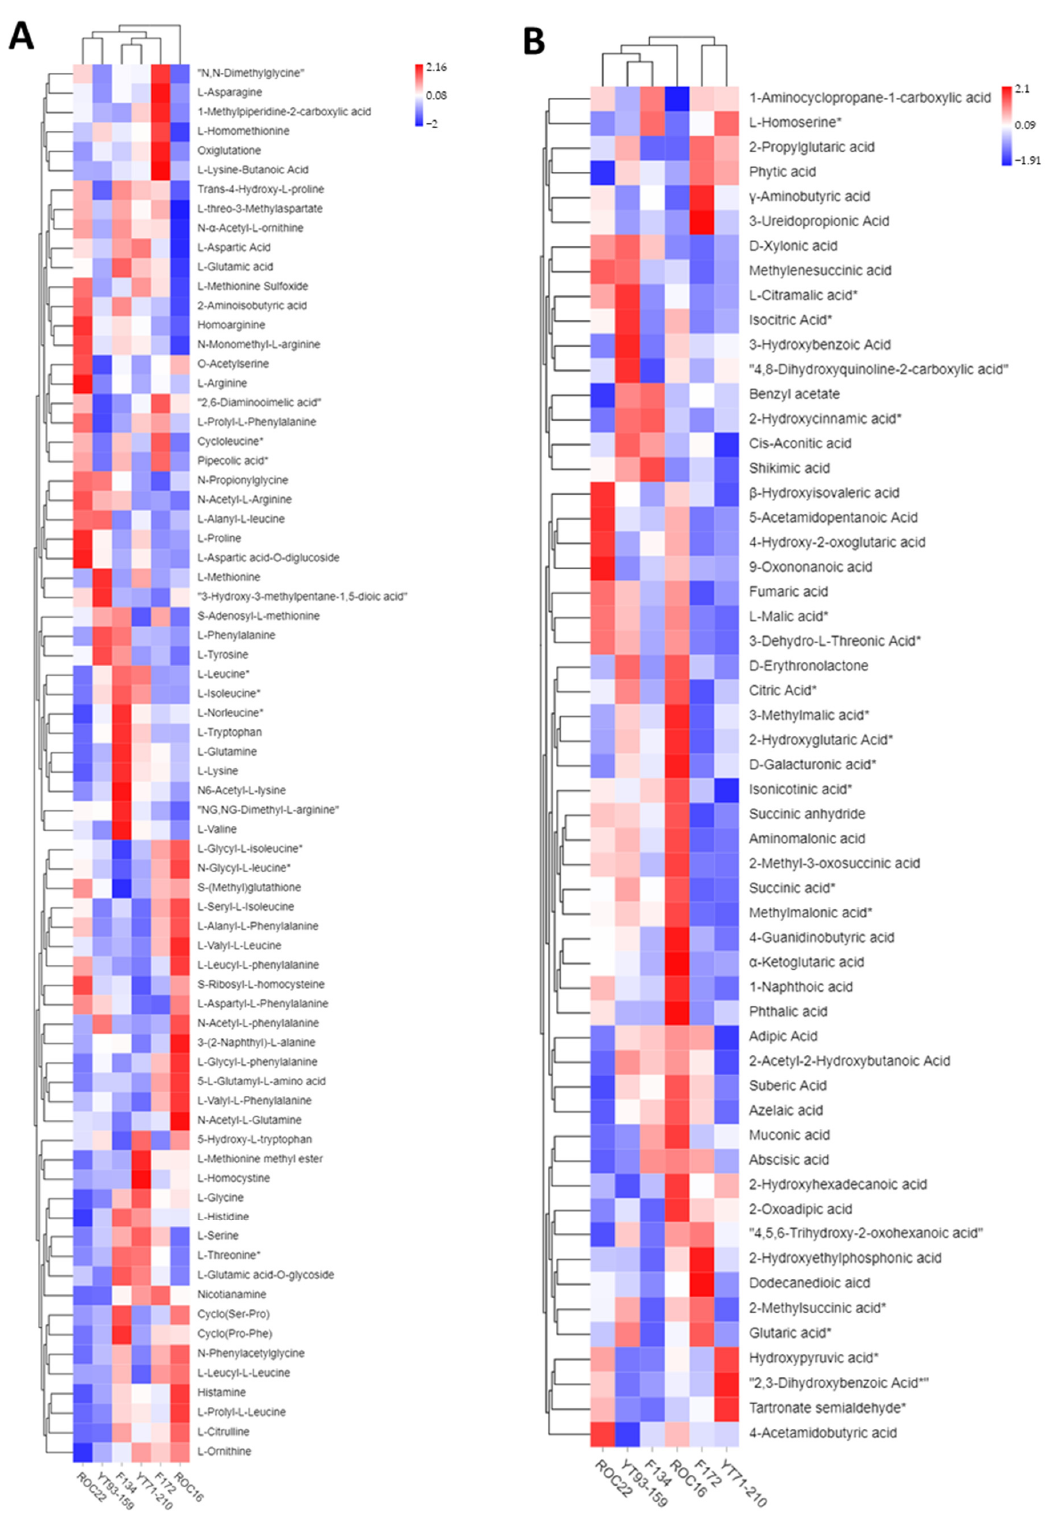
Figure 1. Hierarchical cluster analysis and heat map of amino acid and organic acid compounds in the rind of six sugarcane varieties. ( A ) HCA of amino acid compounds in six sugarcane varieties. ( B ) Diversity of organic acids among six sugarcane varieties. (*) means isotopes. The row signifies the individual compounds (amino acids and organic acids) whereas the column characterizes the six sugarcane varieties. The heat map was generated by the peak area of the individual